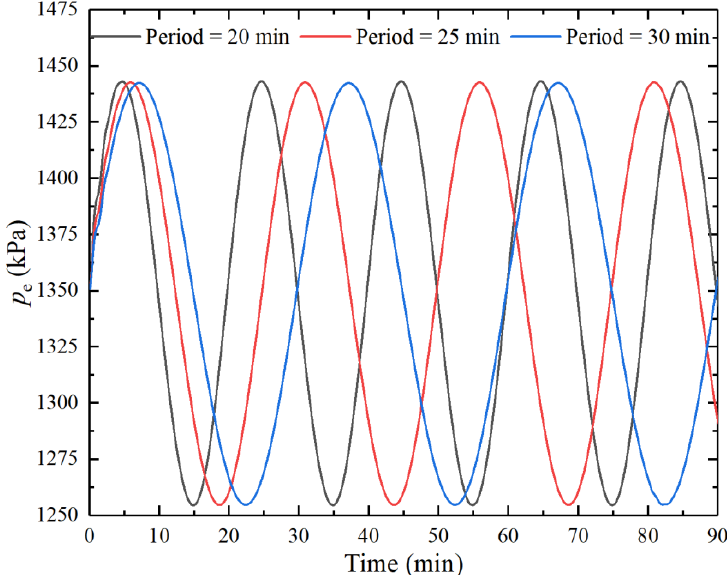
Figure 12. Evaporating pressure under different periods.